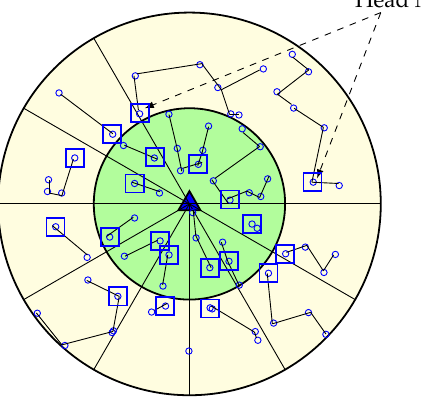
Figure 12. Avoidance of long distance communication by selecting more than one HN for a sector.